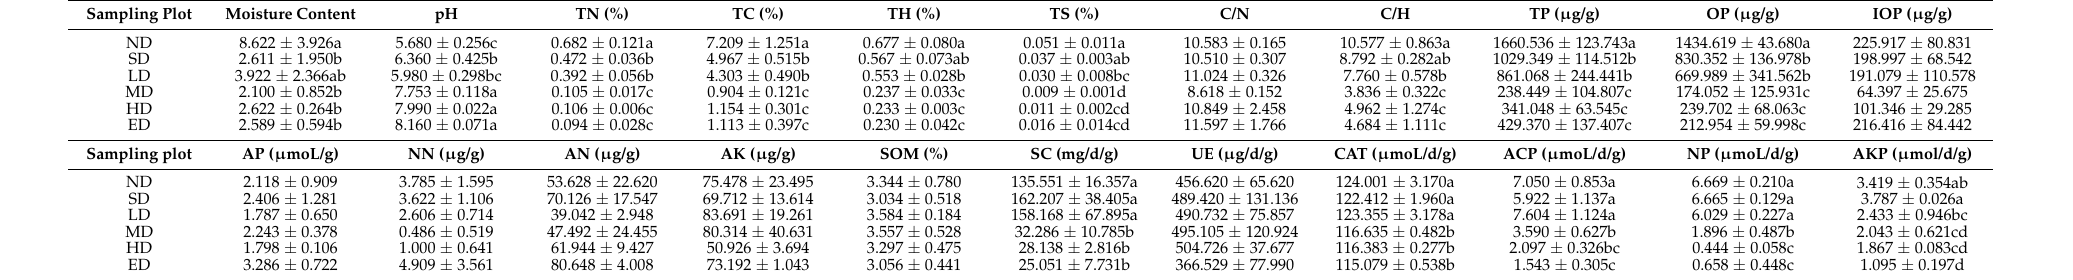
Table 1. The soil chemical/physical properties and enzyme activities at different grassland degradation gradients. Sampling